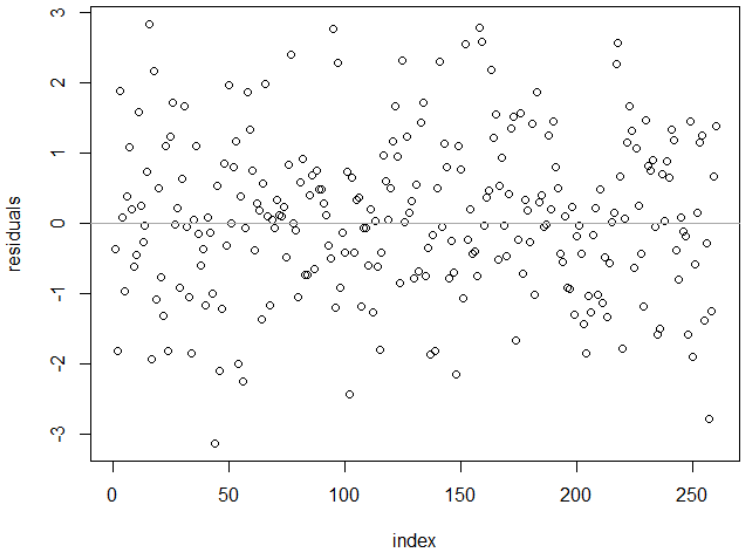
Figure 14. OLS regression residual plot for cell B.